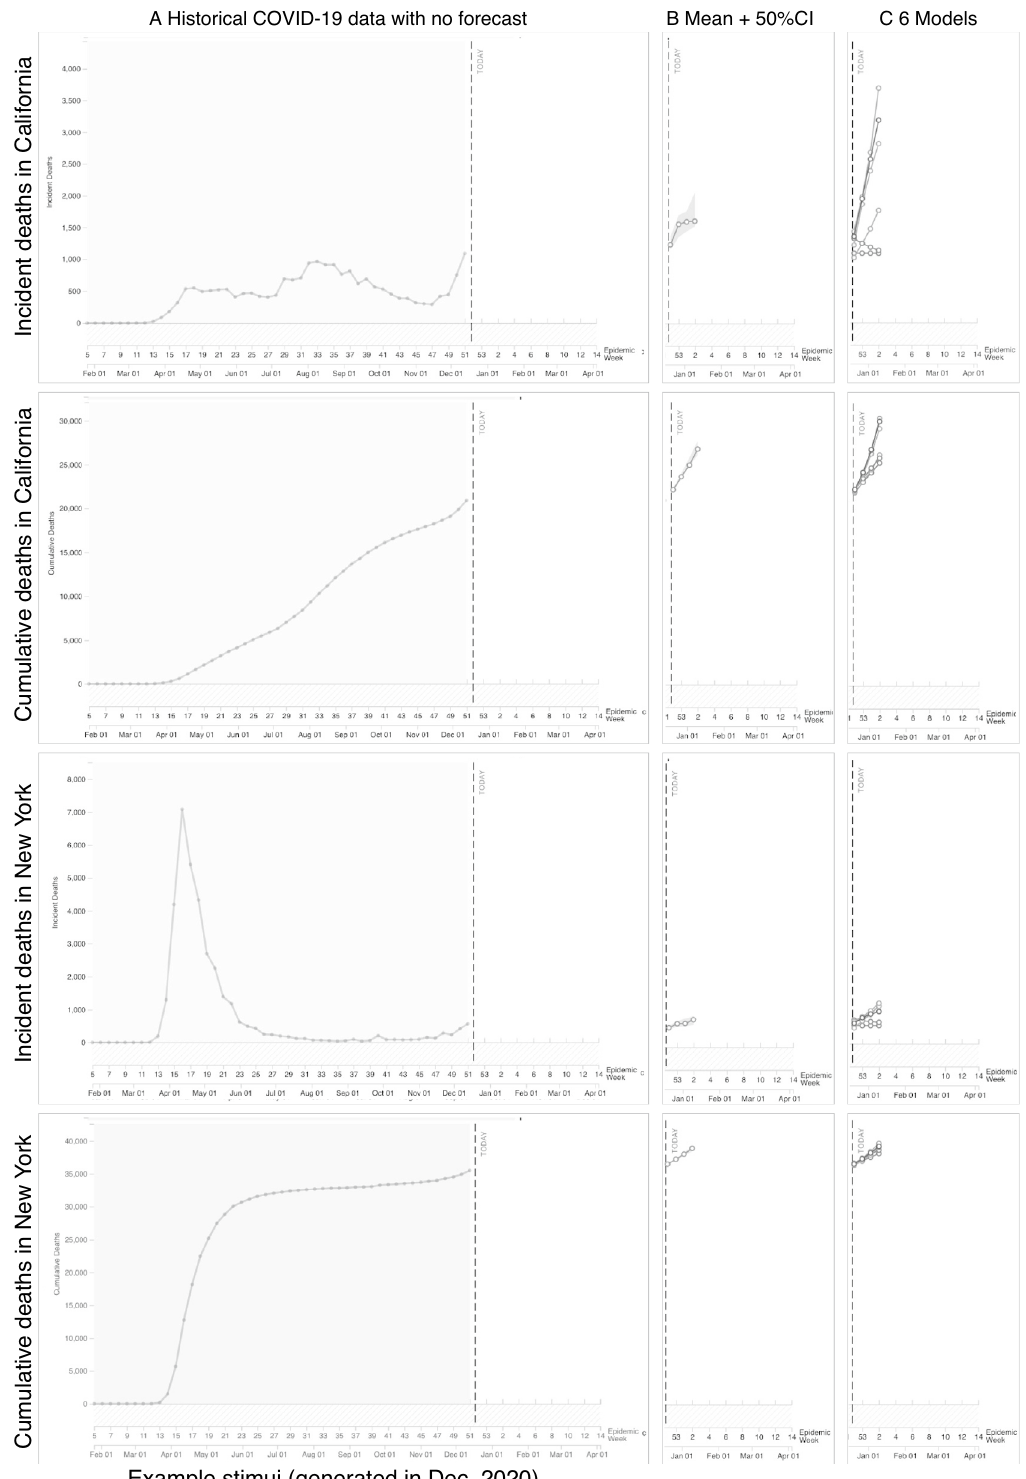
Figure 3. Left of figure shows line charts displaying historical COVID-19 mortality data with incident and cumulative y-axis for California and New York used in Experiment 2. Right of figure shows the visualization forecasts that were added to the data (B. CI 50 and C. 6